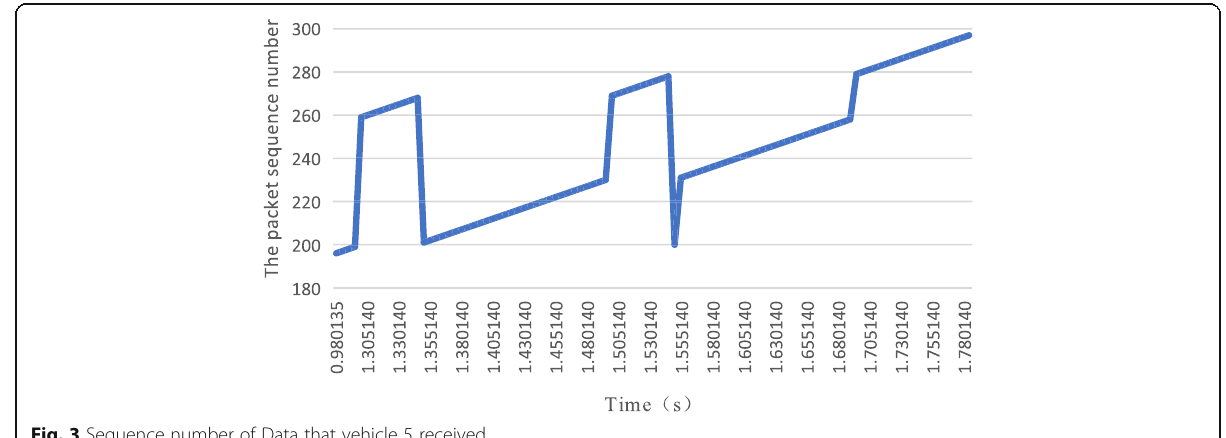
Fig. 3 Sequence number of Data that vehicle 5